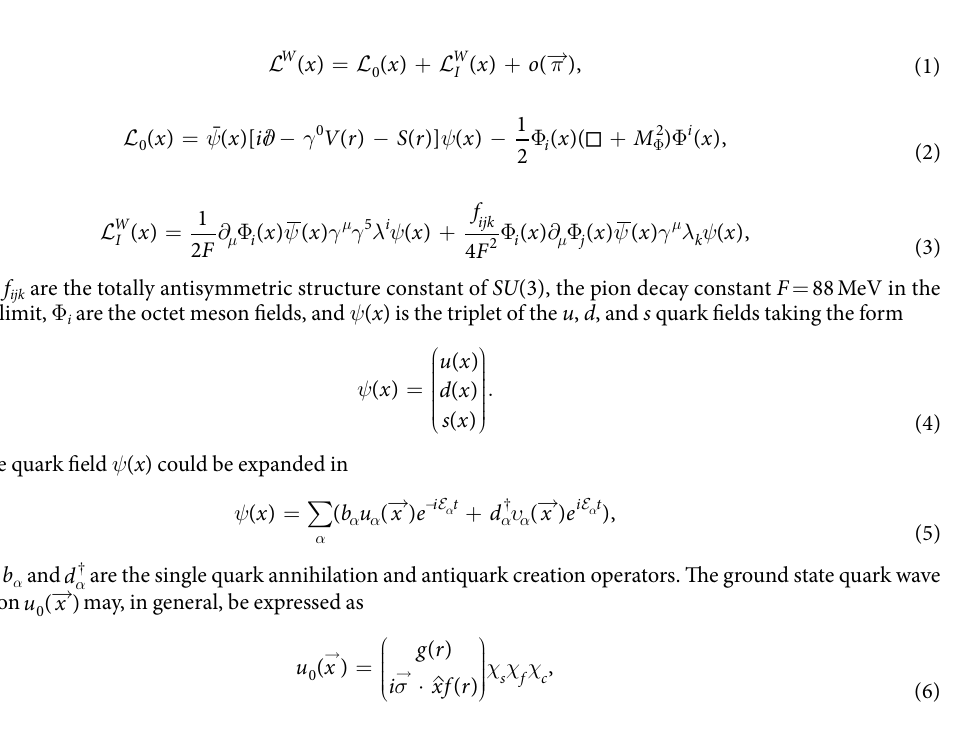
Figure 2. The densities of charge and magnetization from the pion cloud taken from ref. 37. Left panel: 4 π r 2 ρ ( r ) for the isovector Pauli (upper band) and Dirac (lower band) form factors. Right panel: 4 π r 2 ρ ( r ) for the isovector magnetic (upper band) and electric (lower band) Sachs form